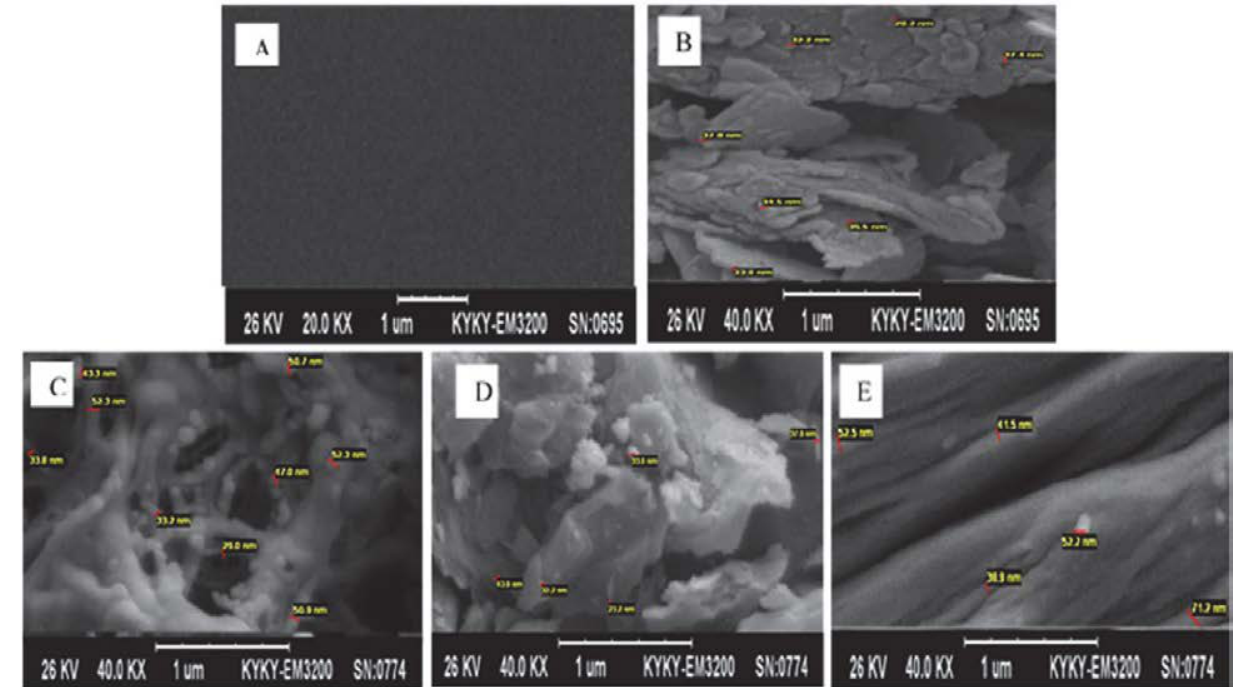
Figure 1. The SEM images of A) bare GCE, B) GO/GCE, C) SF/GCE, D) SF/GO/GCE and E) AuNPs/SF/GO/GCE electrodes